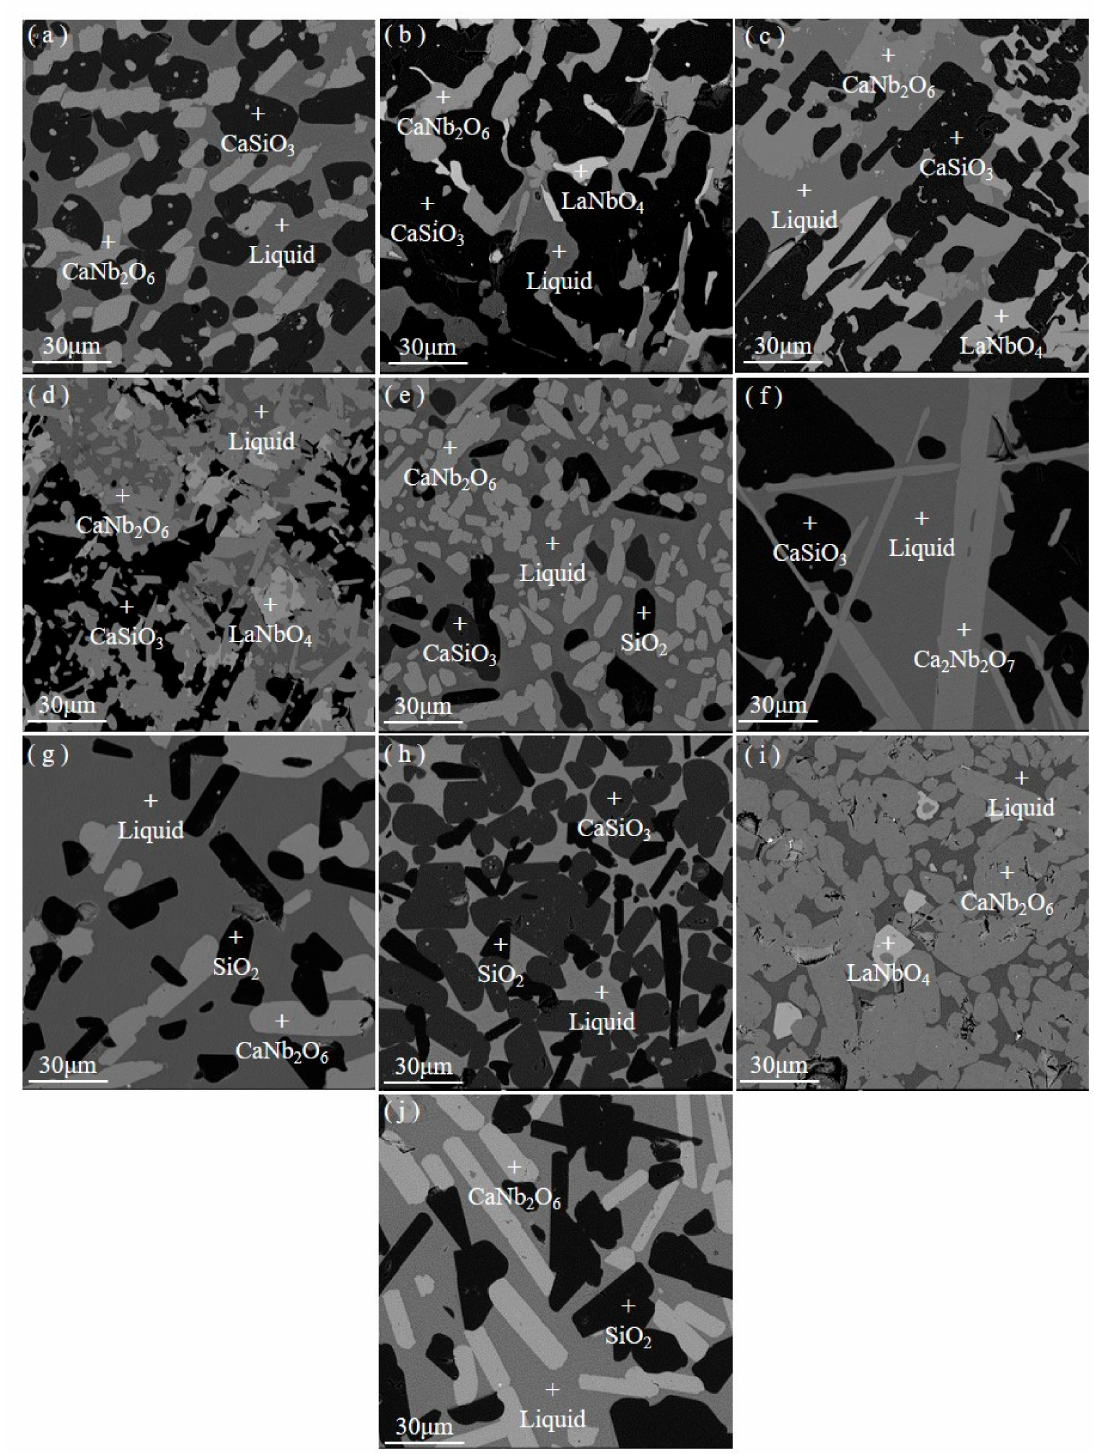
Figure 2. SEM photos of high temperature equilibrium experiment slags. ( a ) slag 1 (L+CN+CS), ( b ) slag 2 (L+CN+CS+LN), ( c ) slag 3 (L+CN+CS+LN), ( d ) slag 4 (L+CN+CS+LN), ( e ) slag 5 (L+CN+CS+S), ( f ) slag 6 (L+C 2 N+CS), ( g ) slag 7 (L+CN+S), ( h ) slag 8 (L+CS+S), ( i ) slag 9 (L+CN+LN), and ( j ) slag 10